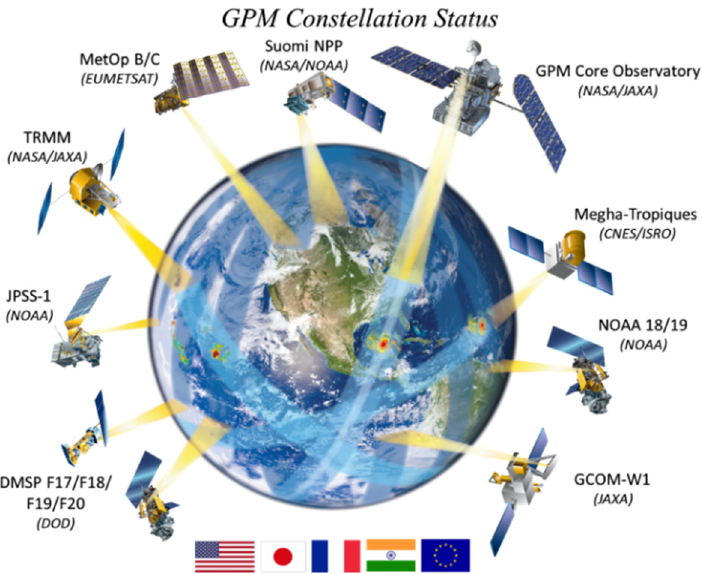
Figure 7. The Global Precipitation Measurement (GPM) constellation and member satellites with corresponding governmental space agencies. The figure is taken from [34].